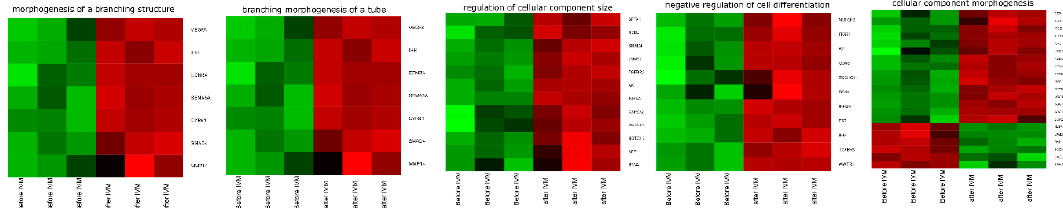
Figure 4. Heat map representations of differentially expressed genes belonging to “cellular component morphogenesis”, “negative regulation of cell differentiation”, “morphogenesis of a branching structure”, “regulation of cellular component size”, and “branching morphogenesis of a tube” GO BP terms. Arbitrary signal intensity acquired from microarray analysis is represented by colors (green, higher; red, lower expression). Log2 signal intensity values for any single gene were resized to Row Z-Score scale (from − 2, the lowest expression to +2, the highest expression for single gene).